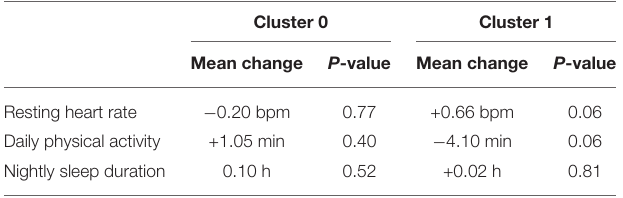
TABLE 3 | Average change in metric between pre- and post-event stratified by